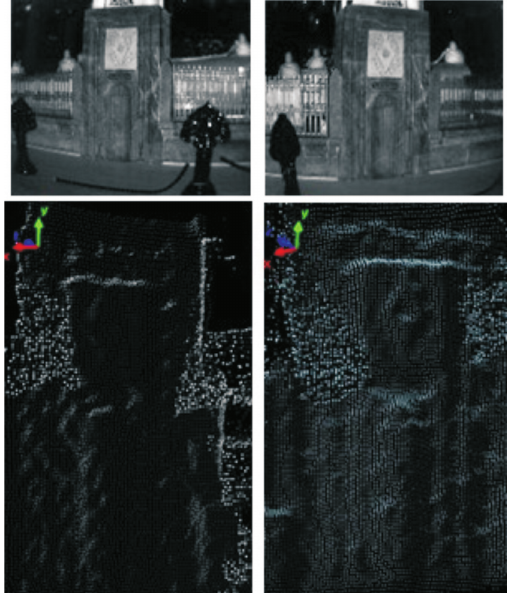
Fig. 4. The overlapping amplitude images (above) and point clouds (below) from two stations by SR4000 camera